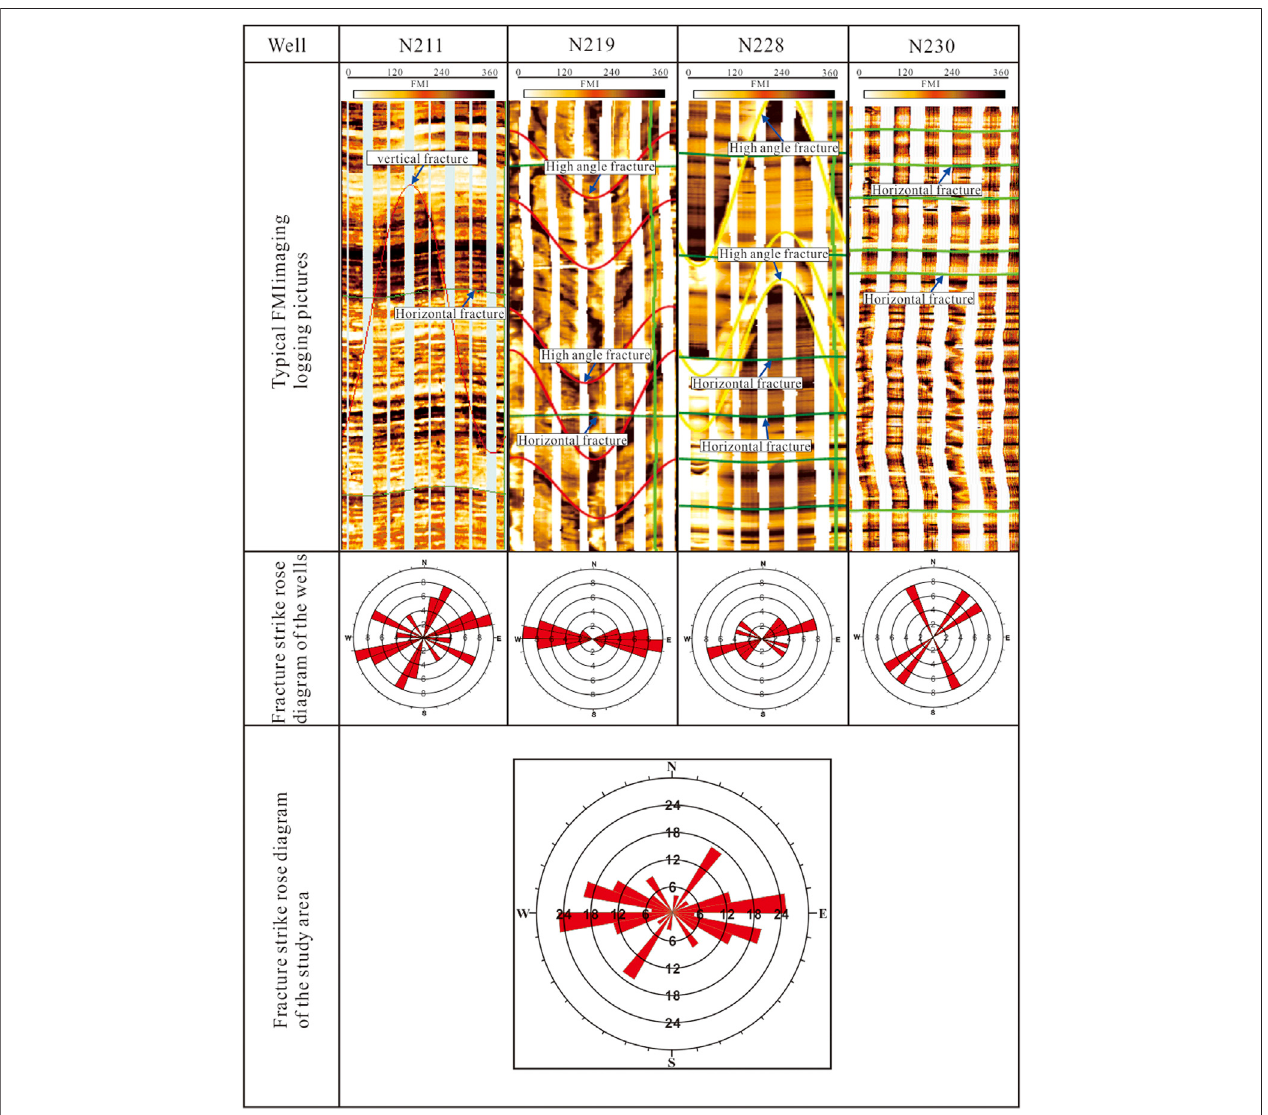
FIGURE 6 | Fracture characteristics and strike rose diagram from image